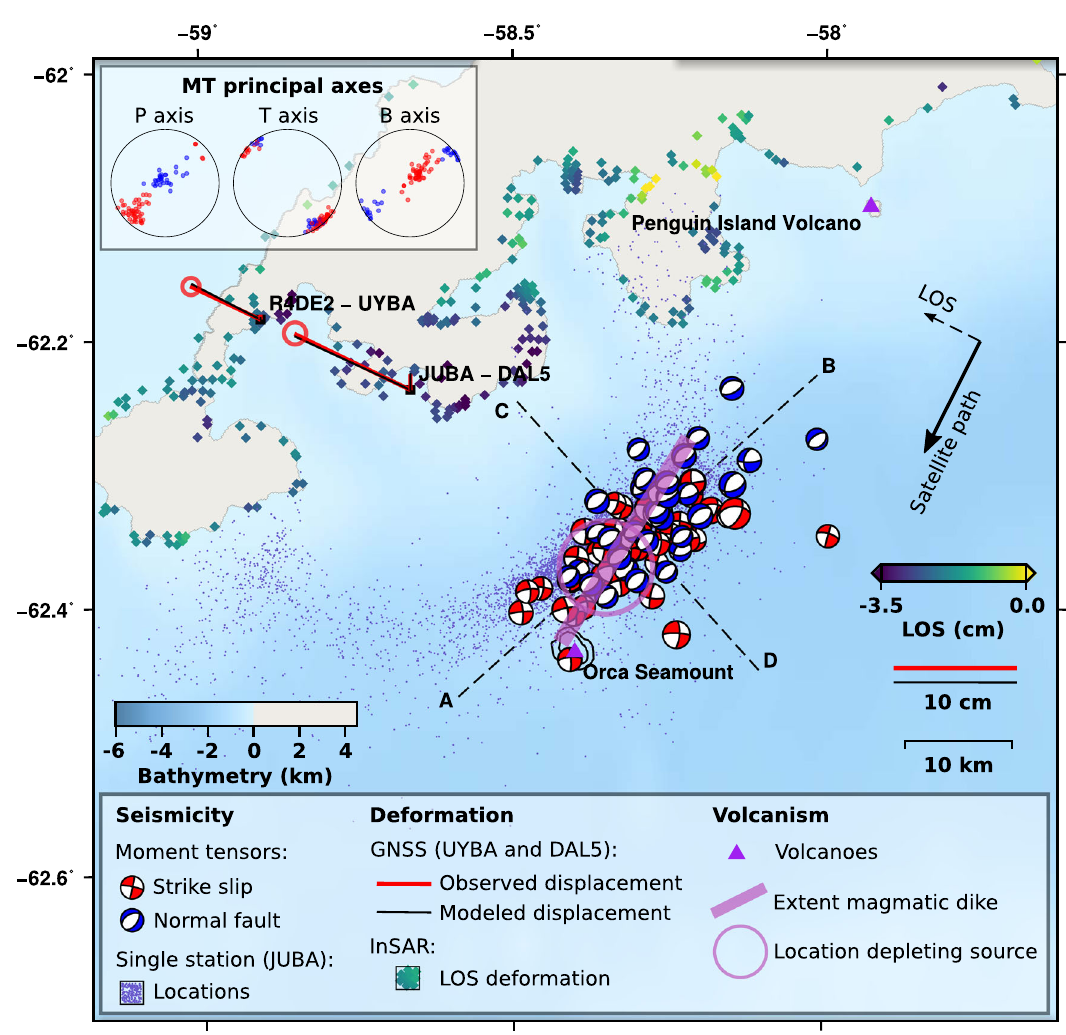
Fig. 2 Overview of seismological and geodetic observations and results. Seismological results include centroids, double couple components of moment tensors, and distribution of principal axes, based on regional data, and locations from the single-station approach. Geodetic modeling results include the locations of the depleting source and sub-vertical dike and the corresponding fi t of GNSS cumulative displacement from 1 August 2020 to 1 February 2021 (horizontal uncertainty ellipses are plotted for 1 standard deviation, while the corresponding vertical uncertainties are 0.2 and 0.3 cm at DAL5 and UYBA, respectively), together with the downsampled spatial distribution of displacements along the line of sight (LOS) from InSAR processing (for the time period of 17 July 2020 to 6 February 2021); due to the different orientation of satellite trajectory and displacement vectors, LOS displacement projections are smaller than absolute displacements recorded by GNSS data. Local stations JUBA (seismic) and DAL5 (GNSS) are located at the Carlini Antarctic base (Argentina) and R4DE2 (seismic) and UYBA (GNSS) at the Artigas Antarctic base